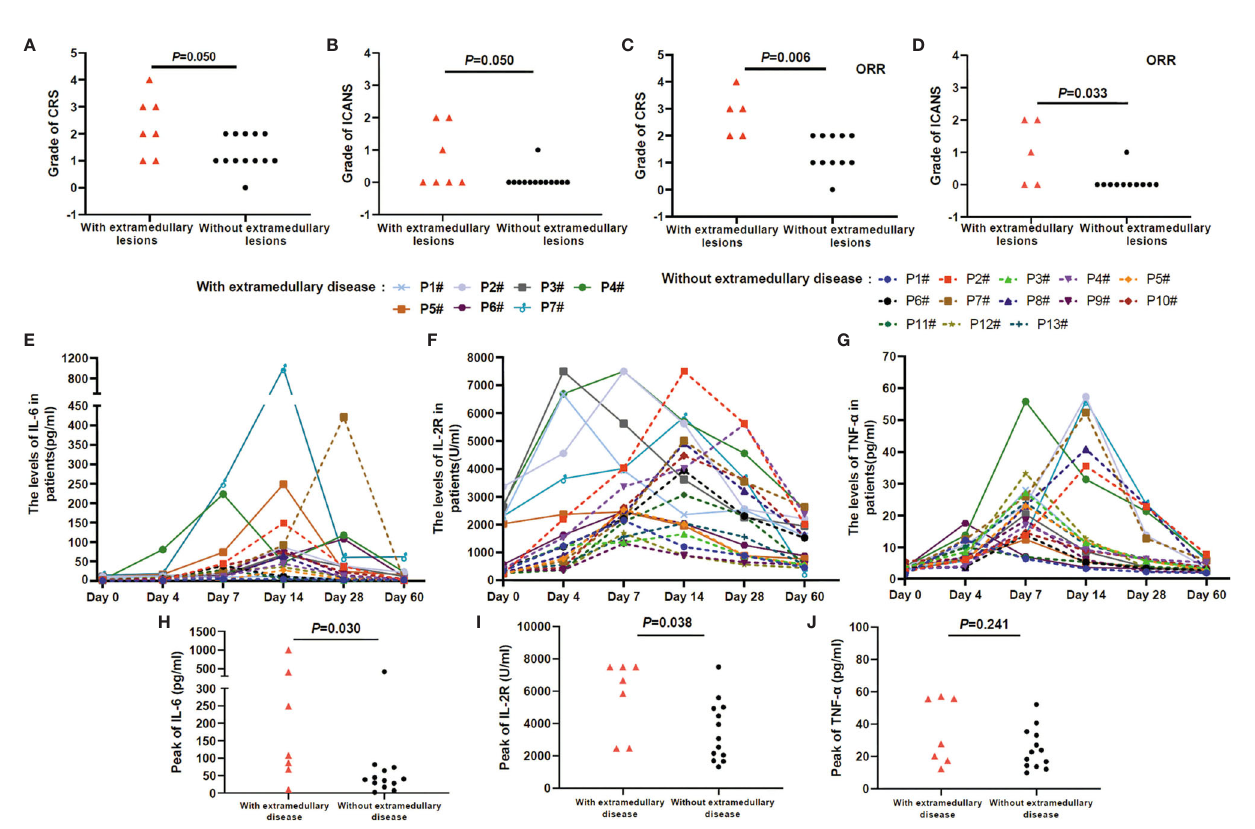
FIGURE 5 | AEs and the serum levels in the anti-BCMA-CAR T cell therapy. (A, B) The grades of CRS and ICANS had no different in patients with and without extramedullary disease ( P CRS = 0.050 and P ICANS = 0.050). (C, D) In patients obtained an ORR reaction, the grades of CRS and ICANS in patients with extramedullary disease was higher than that of in patients without extramedullary disease ( P CRS =0.006 and P ICANS = 0.033). (E – G) The serum levels of IL-6, IL-2R, and TNF-a peaked 4 to 7 days after the infusion of anti-BCMA CAR T cells and declined 12 to 21 days. (H, I) IL-6 and IL-2R levels were higher in patients with extramedullary disease group than that of in patients without extramedullary disease group ( P IL-6 = 0.030 and P IL-2R = 0.038). (J) There was no different in the TNF-a level between the two groups ( P TNF-a = 0.241).